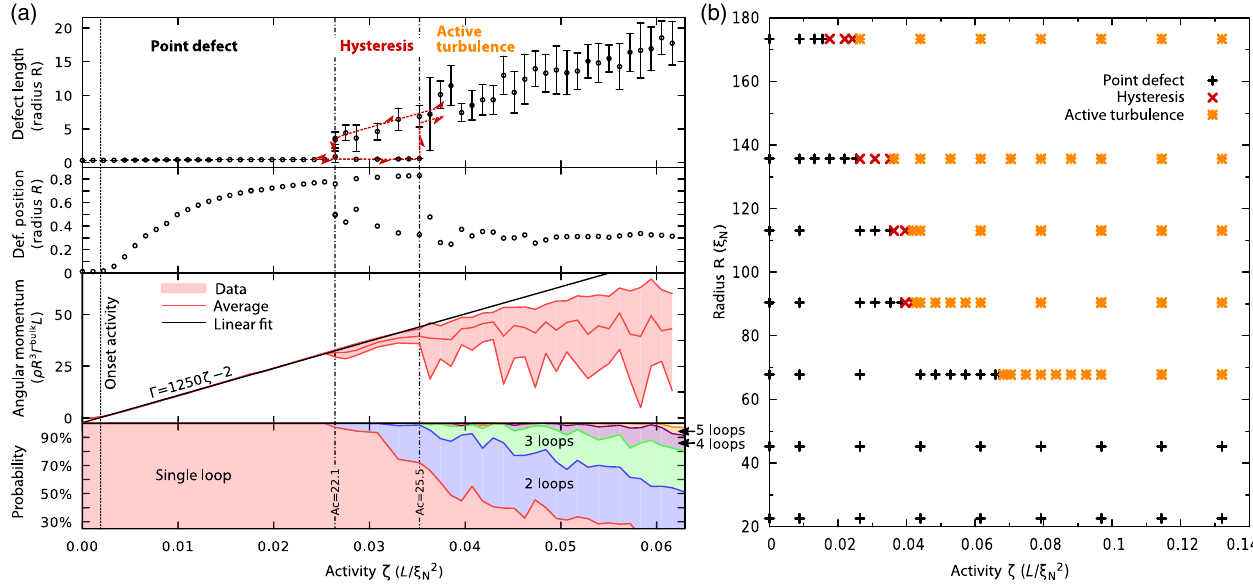
FIG. 2. Analysis of active nematic regimes in the confinement of a spherical droplet. (a) Multiple material characteristics of the three- dimensional active nematic in spherical droplet confinement of radius R ¼ 136 ξ , with perpendicular surface alignment dependent on N the activity. The calculations are performed for increasing or decreasing activity, clearly showing a pronounced hysteresis. At each activity change, previous structure is taken as the initial condition, and simulation is run for 23 000 τ for each data point. The top panel N shows the total length of defect loop cores at a given activity, with the bars indicating the standard deviation of the natural oscillation of the defect length over time. The second panel in (a) shows the average radial distance of the defect core regions from the droplet center. The third panel gives the total angular momentum set by the flow and its standard deviation in time. The bottom panel gives the probability for finding the given number of defect loops within the droplet. Note three active regimes — point defect, hysteretic regime, and developed active turbulence — each with a different response of the active material characteristics. The linear fit of the angular- momentum dependence on the activity, in the point-defect regime, is used to set the onset activity below which the vortex flow profile has negligible magnitude and the point defect remains at the droplet center. Graphs of angular momentum and probability are shown only for hysteresis behavior at decreasing activity. The hysteretic region is delimited by activity numbers Ac ≈ 22 . 1 and Ac ≈ 25 . 5 , for the considered droplet size. (b) Phase diagram of active regimes in spherical droplets with perpendicular surface alignment, as given by droplet radius R and activity ζ